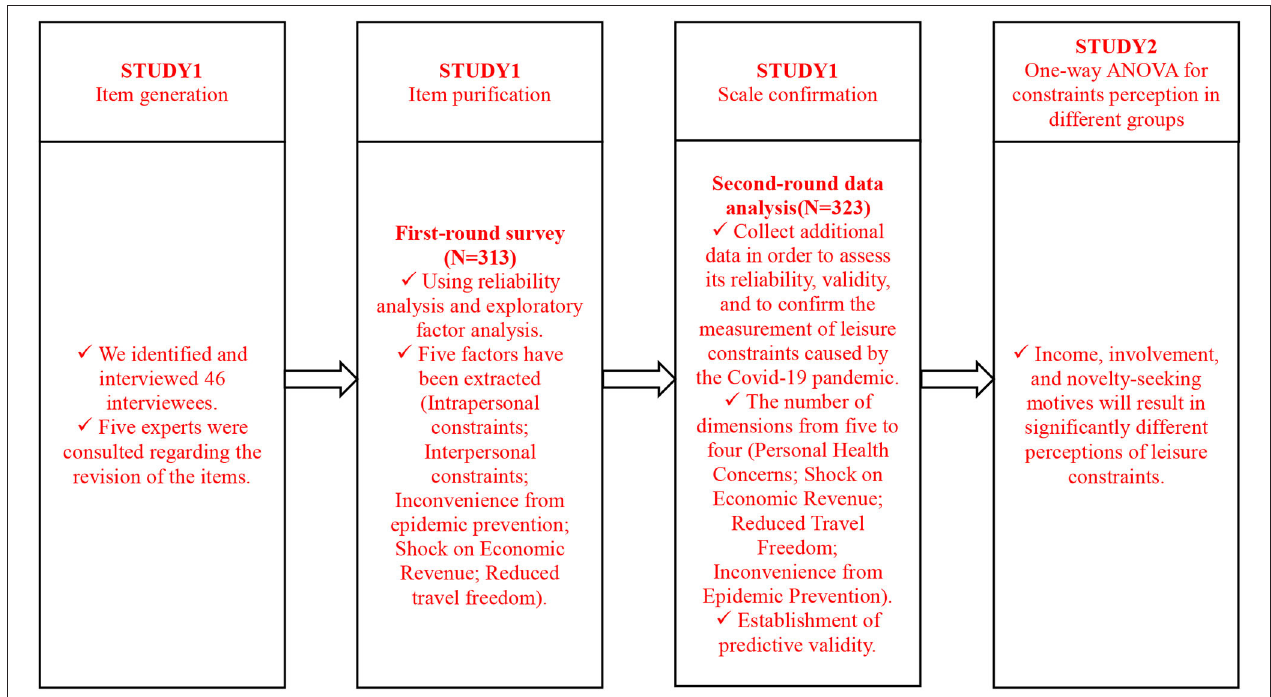
FIGURE 1 | Research